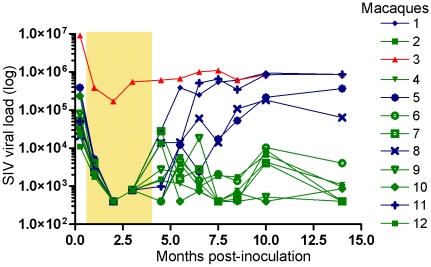
Viral loads in macaques after SIVmac239 infection.Twelve 4-year-old male Cynomolgus macaques (Macaca fascicularis) were infected intravenously with pathogenic cell-free SIVmac239. Treatment with tenofovir was started ten days after inoculation and provided by subcutaneous injections for 16 weeks, as indicated by the shaded area. Viral loads are depicted longitudinally for each animal. Animals 2, 4, 6, 7, 9, 10 and 12 were designated longterm controllers (LC, green), as defined by maintained viral load below 10,000 copies/ml after treatment interruption. Animals 1, 5, 8 and 11 were designated transient controllers (TC, blue) due to progressive increase of viral load following treatment interruption and animal 3 non-controller (NC, red) due to persistent high (over 100,000 copies/ml) viral replication throughout the study. Statistically significant differences were observed between the LC and NC/TC groups with regards to viral load starting from 4.5 months after inoculation (p = 0.002, Mann-Whitney non-parametric test and p<0.0001, two-way repeated measures analysis of variance model).